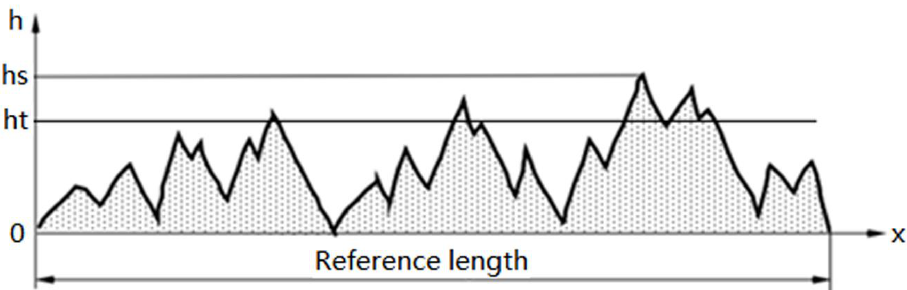
Figure 1. Schematic of the macrotexture morphology of the aggregate surface.